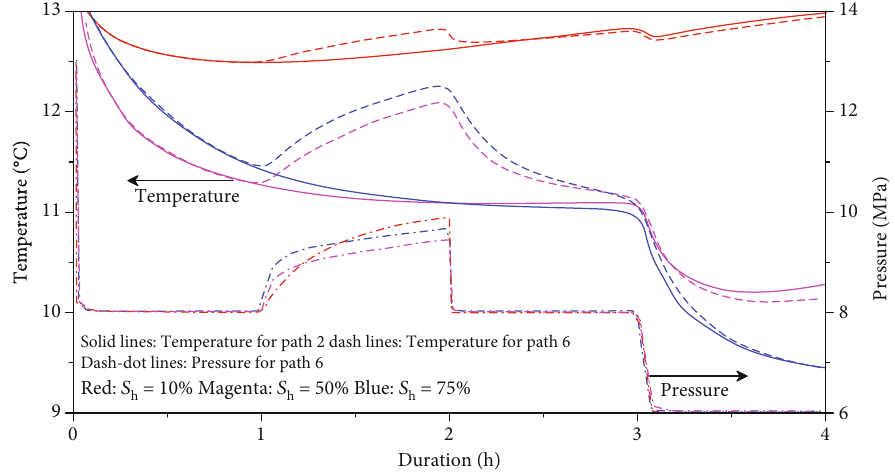
Figure 13: Formation pore pressure-temperature response to the shut-in